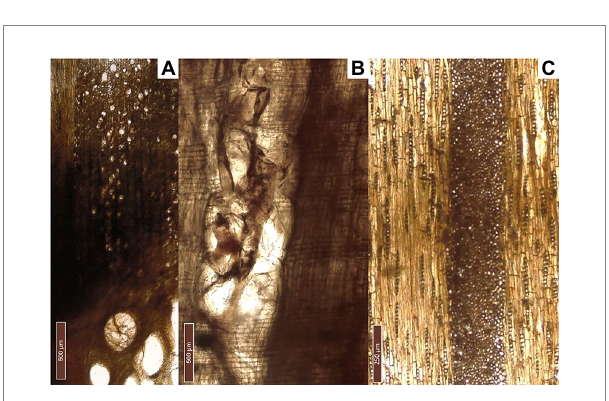
FIGURE 3 Diagnostic sections of Quercus sect. robur (F1-MARM): (A) transversal section, (B) radial section, and (C) tangential